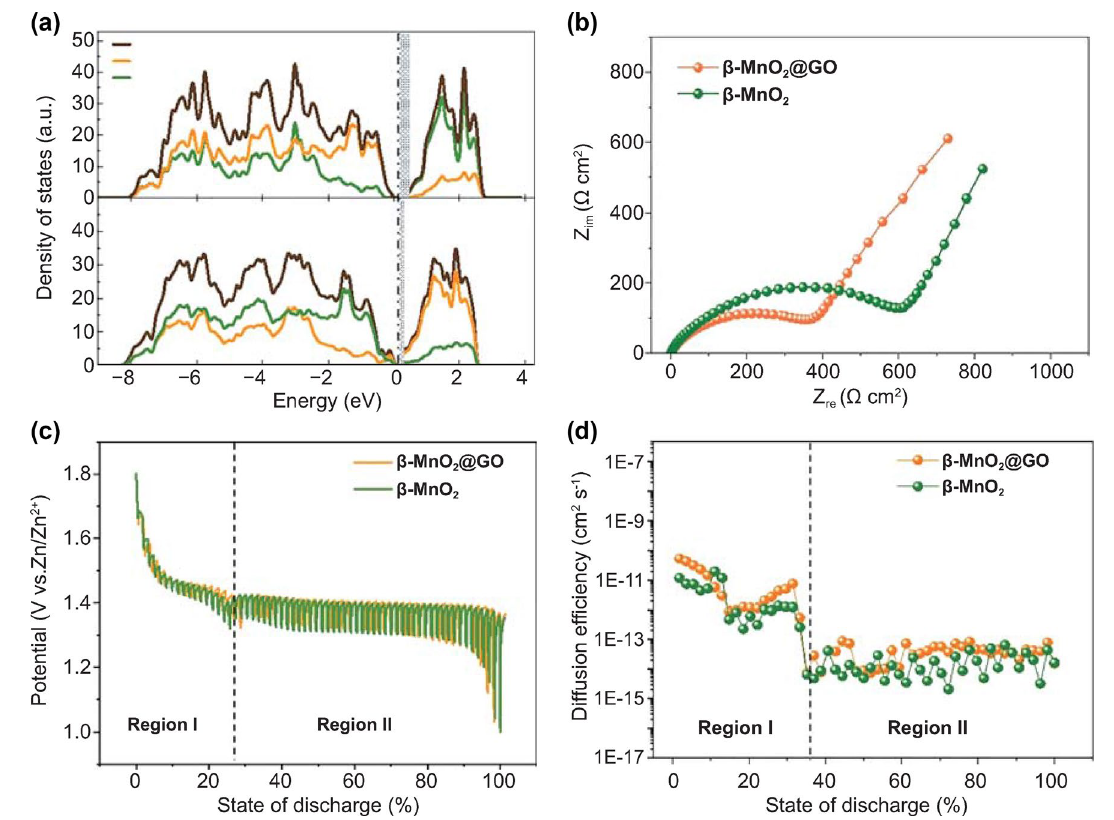
Fig. 4 a Calculated electron density of states of β-MnO 2 with and without V O . Energies are referenced to the Fermi level. b EIS spectra of elec- trodes with β-MnO 2 and β-MnO 2 @GO as active materials. c , d GITT curves and calculated diffusion